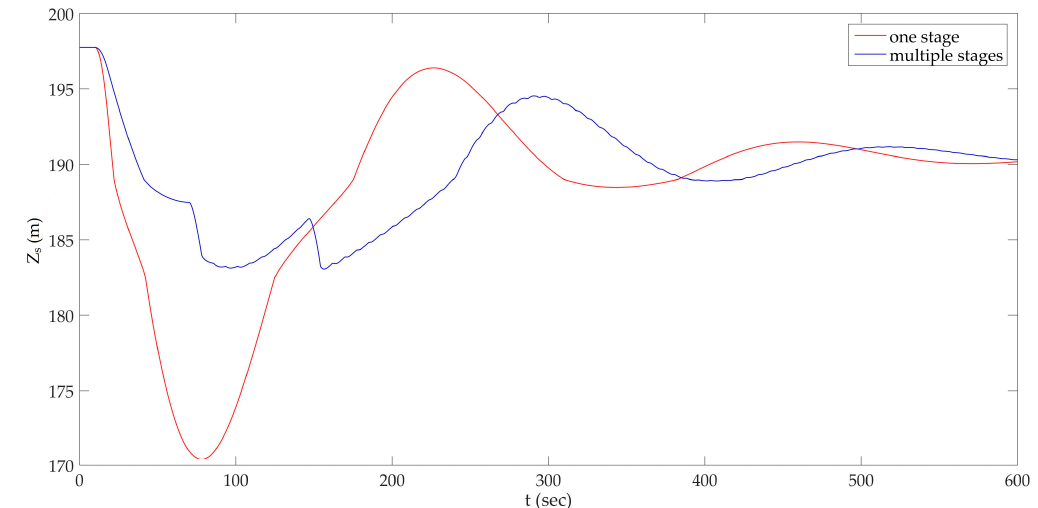
Figure 14. Killing surge by acceptance of load in three stages.